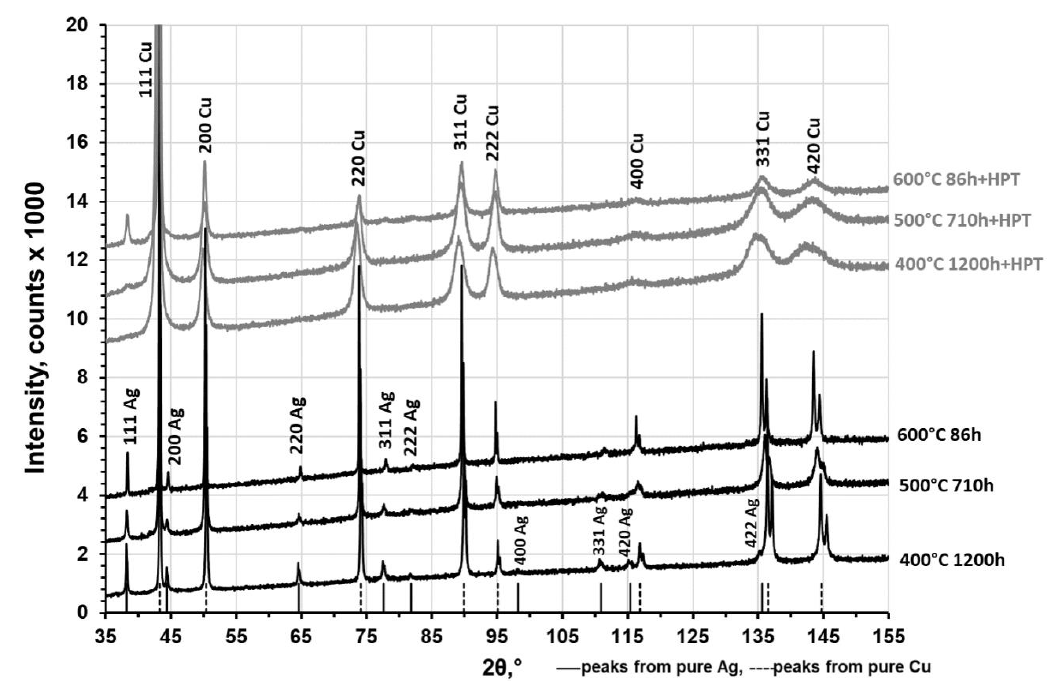
Figure 5. X-ray diffraction patterns of the Cu–8wt.%Ag alloy after annealing at different temperatures before and after HPT.